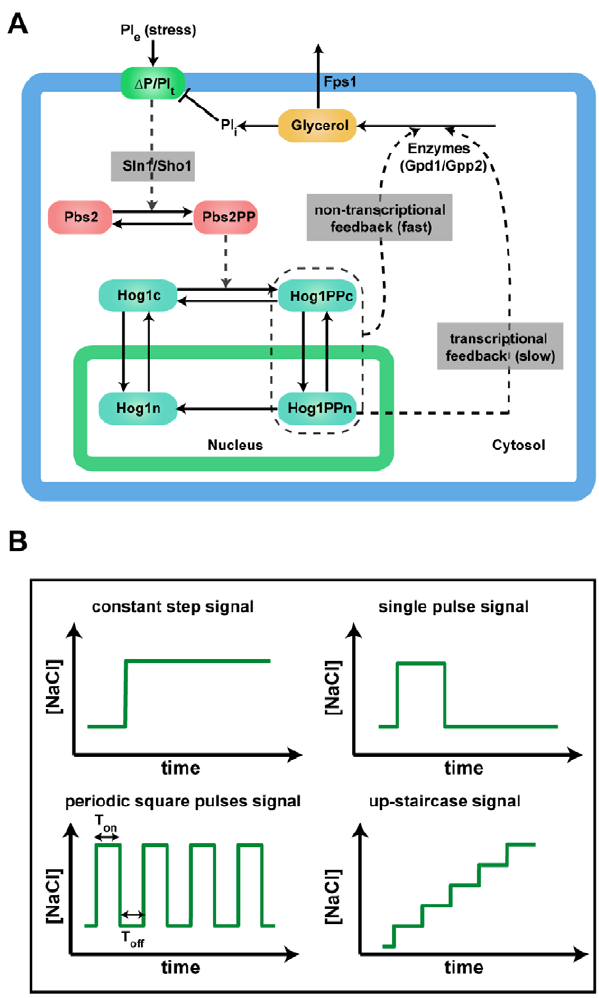
Figure 1. Model scheme for osmosensing network and the osmotic stress signals. ( A ) Scheme of the model for osmosensing network. ‘‘Non-transcriptional feedback loop’’ denotes the Hog1 kinase dependent regulation of glycerol production. ‘‘Transcriptional feedback loop’’ stands for transcriptional regulation of the enzymes responsible for glycerol production. The gray boxes are modeled with coarse- grained black box approaches. ( B ) Different types of osmotic change signals considered in this